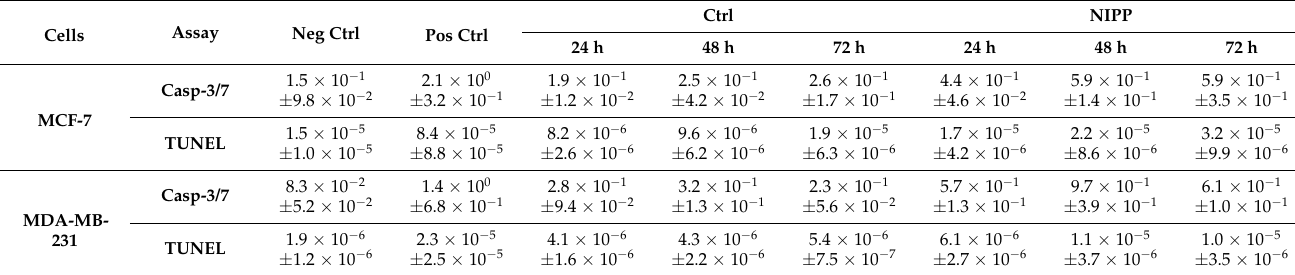
Table 1. Absolute representation of apoptosis. As shown in Figure 7a,b, the breast cancer cells MCF-7 and MDA-MB-231 were treated with NIPP for 20 s and incubated for an additional 24, 48, and 72 h. Subsequently, caspase-3/-7 (Casp-3/7) and the absolute apoptotic events, the measured values (apoptotic signals/cell) are shown without normalization of NIPP treatment to controls. Additionally shown are negative controls (Neg Ctrl) and positive controls (Pos Ctrl) for both assays in both cell lines. The results are displayed as mean ± standard deviation.